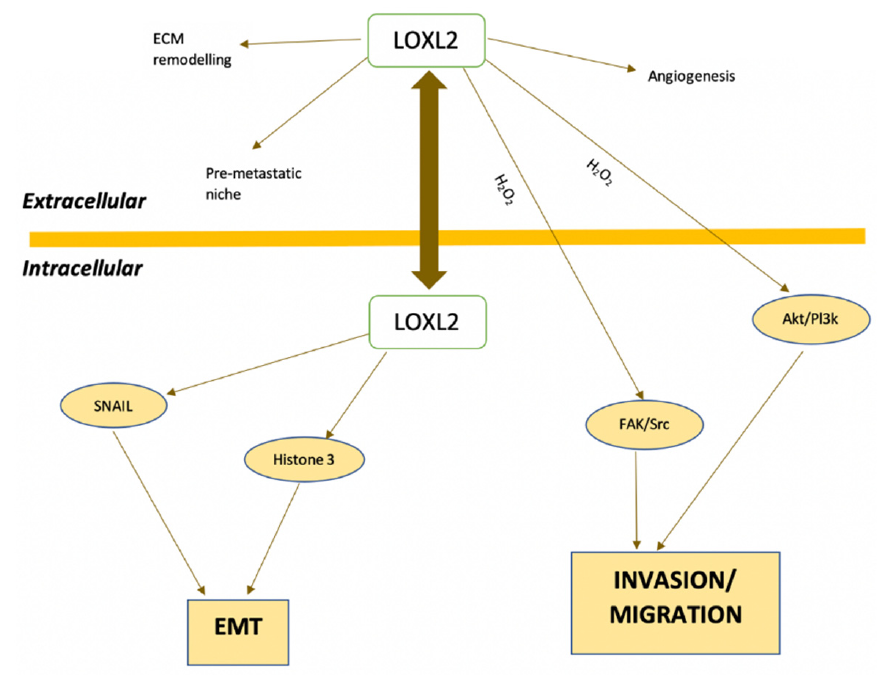
Figure 4. Intracellular and extracellular pathways involving LOXL2 in cancer metastasis-related processes. Akt, protein kinase B; EMT, epithelial–mesenchymal transition; FAK, focal adhesion kinase; Pl3k, phosphoinositide 3-kinases; SNAIL, zinc finger protein; Src, proto-oncogene tyrosine-protein kinase Src. Adapted from [31,32].